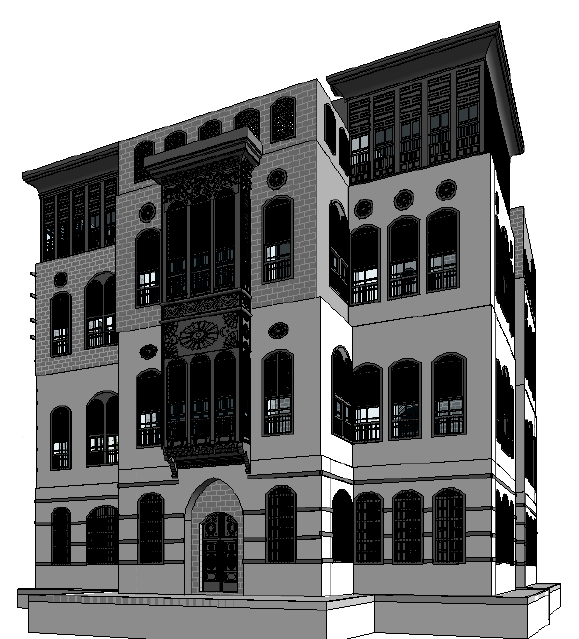
Figure 3: 3D model of Nasif Historical House based on